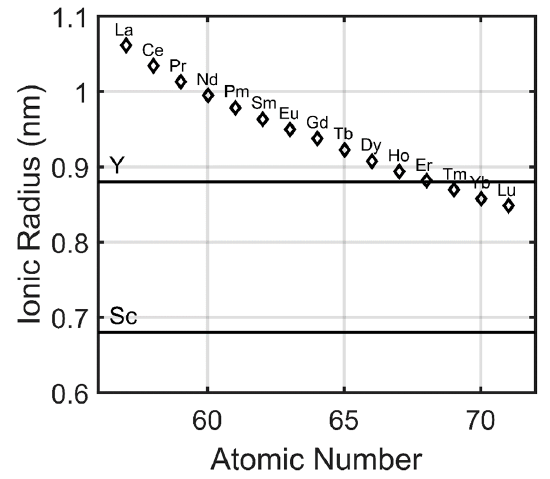
Figure 3. Ionic radius of the trivalent rare earth (RE) cations (adapted from Gupta [15]). Lanthanide contraction is observed due to the weak shielding of the valence electrons by the 4f electrons. Certain properties of rare earth carbonate phases can be correlated with atomic